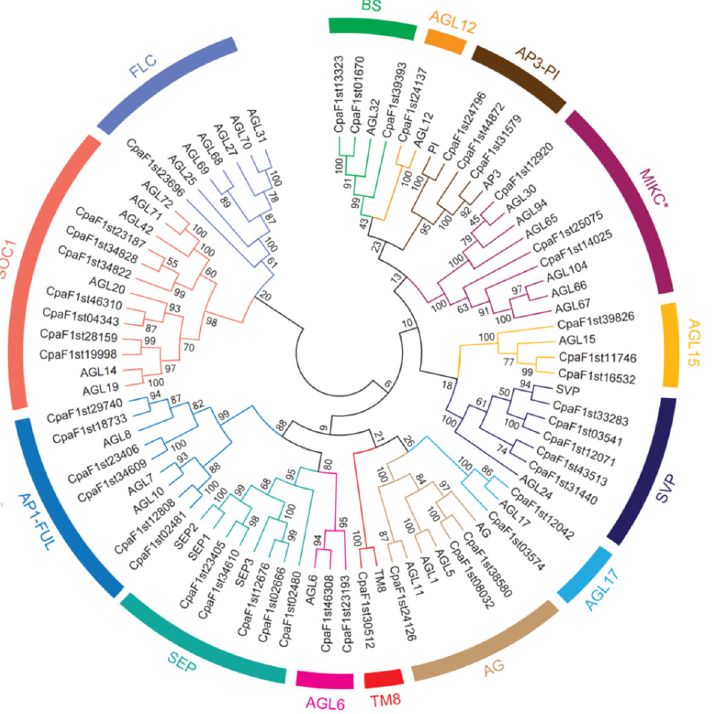
Figure 3. Phylogenetic analysis of MIKC-type MADS-box proteins in C. paliurus (45). A neighbor- joining (NJ) tree was constructed using 45 MADS-box sequences. The tree further clustered into 14 subfamilies, which are shown in different colors.